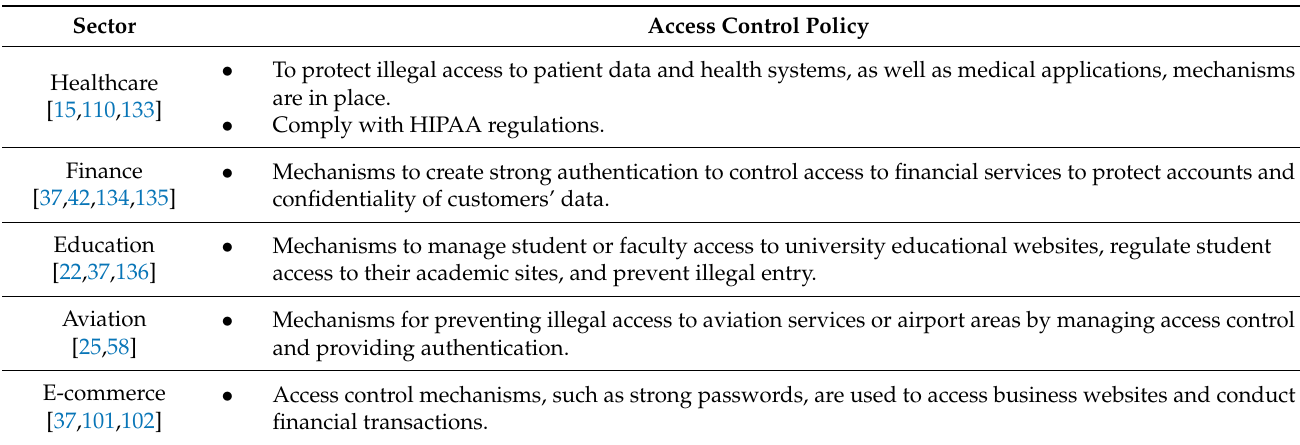
Table 9. Access control policy among different